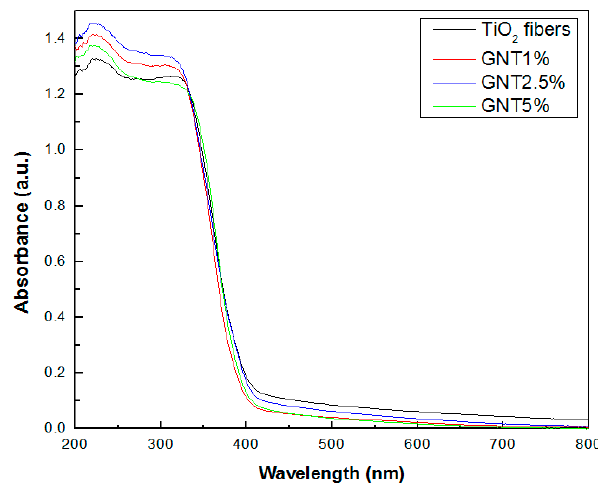
Figure 6. UV-vis absorption spectra of calcinated TiO 2 and TiO 2 /g-C 3 N 4 fibers.